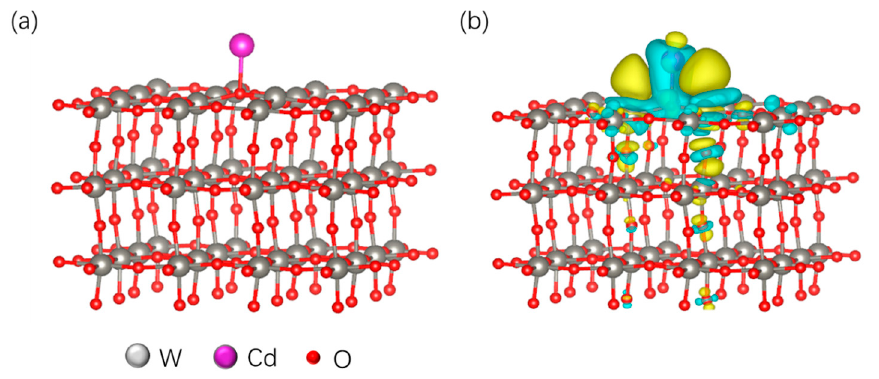
Figure 7. The adsorption of Cd 2+ on the WO 3 surface and the transfer of the electron. ( a ) The adsorption site of Cd 2+ on the WO 3 surface; ( b ) The electron transfer at the interface after the adsorption of Cd 2+ .